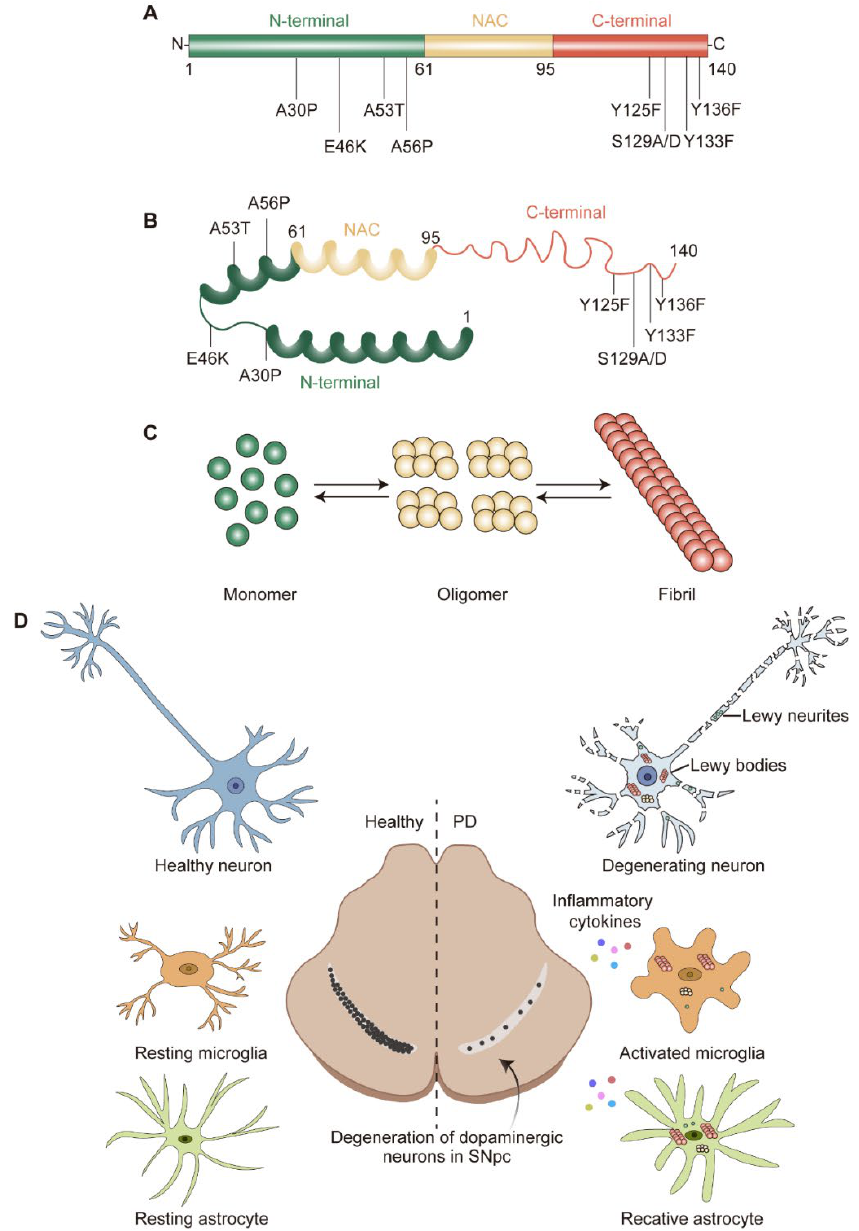
Figure 1. α -syn structure and pathological hallmarks of PD: ( A ) Schematic representation of α -syn. α -syn is divided into N-terminal, non-amyloid-beta component (NAC), and C-terminal; three domains highlighted in green, yellow, and red, respectively. Several familial PD-related mutations and post-translational modification sites are denoted. ( B ) Structure of α -syn monomer. ( C ) α -syn equilibrium. α -syn monomer can aggregate into oligomer or fibril. ( D ) Pathological hallmarks of PD. The pathological hallmarks of PD include progress loss of dopaminergic (DA) neurons in the substantia nigra pars compacta (SNpc), misfolded α -syn aggregates and neurites known as Lewy bodies (LBs) and Lewy neurites (LNs), and glial activation. α -syn could transfer to and activate microglia and astrocyte, which in turn release pro-/anti-inflammatory cytokines and contribute to neurodegeneration.